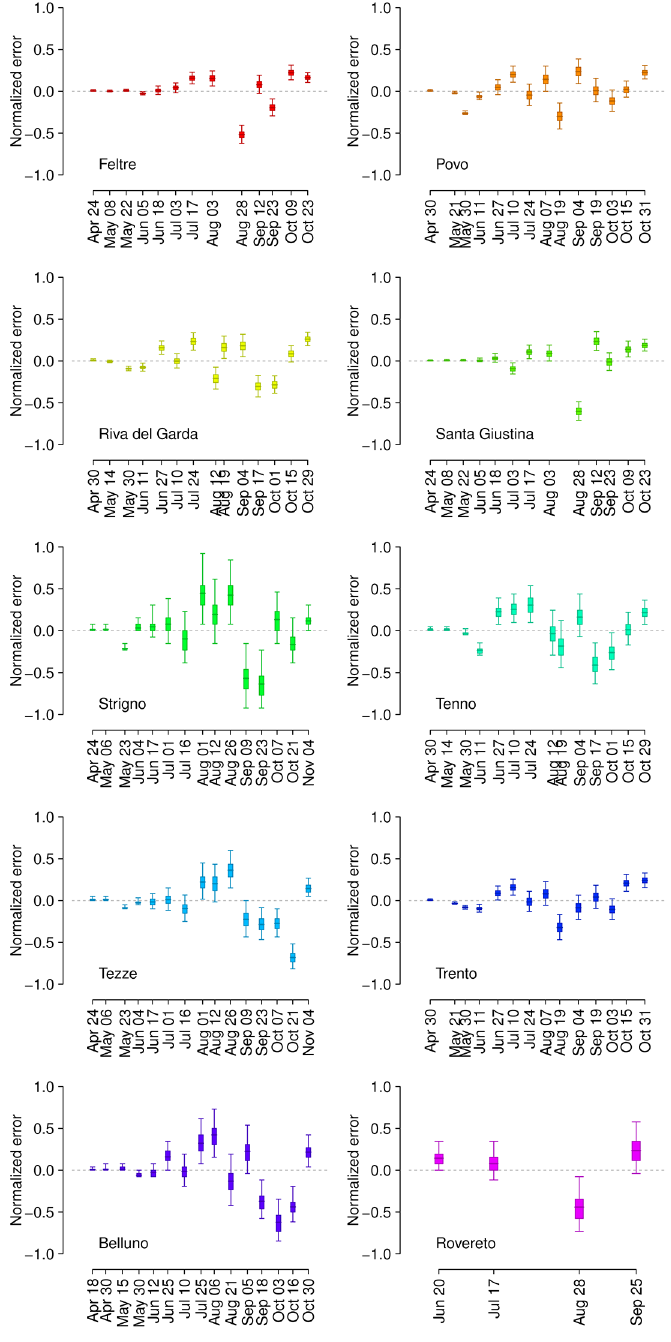
Fig 3. Boxplots of the errors between observed and simulated captures at each capture session in the ten study sites. The errors are normalized by the maximum number of captured females throughout the season.